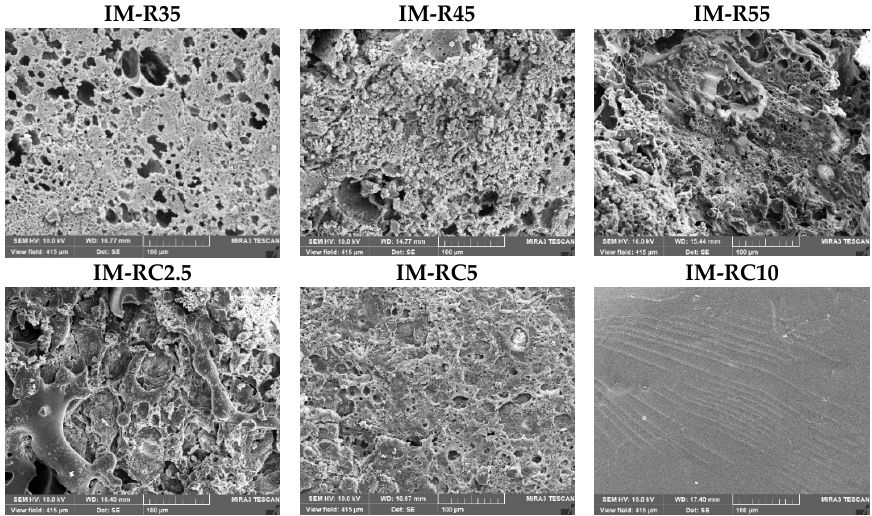
Figure 7. SEM images of freeze-dried IM-loaded rosin/cinnamon oil-based ISGs (500×).